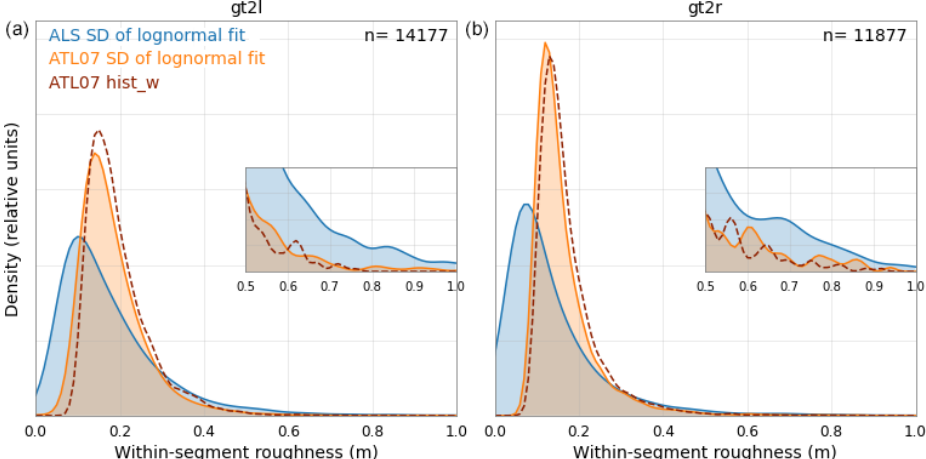
Figure 7. Probability density functions (PDFs) of roughness estimates from all overlapping segments for gt2l (a) and gt2r (b) . Filled curves show the standard deviations of the lognormal fits to the within-segment elevation histograms from ALS (blue) and ATL07 (orange). The dashed red curve shows the ATL07 hist_w parameter, representing the width of the height distribution within segments. The inset axes highlight roughness values between 0.5 and